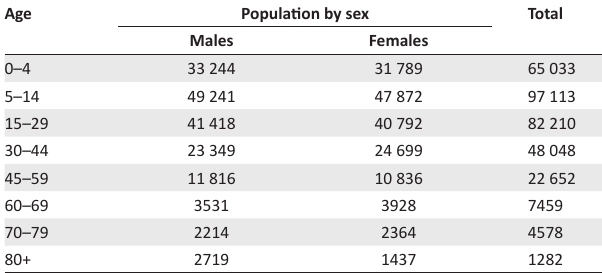
FIGURE 1: Techniques used to collect information on HCC risks, (a) Field meetings; (b) Interview session and (c) Dialogue with community members through their local TABLE 1: Population structure of Mbulu District.